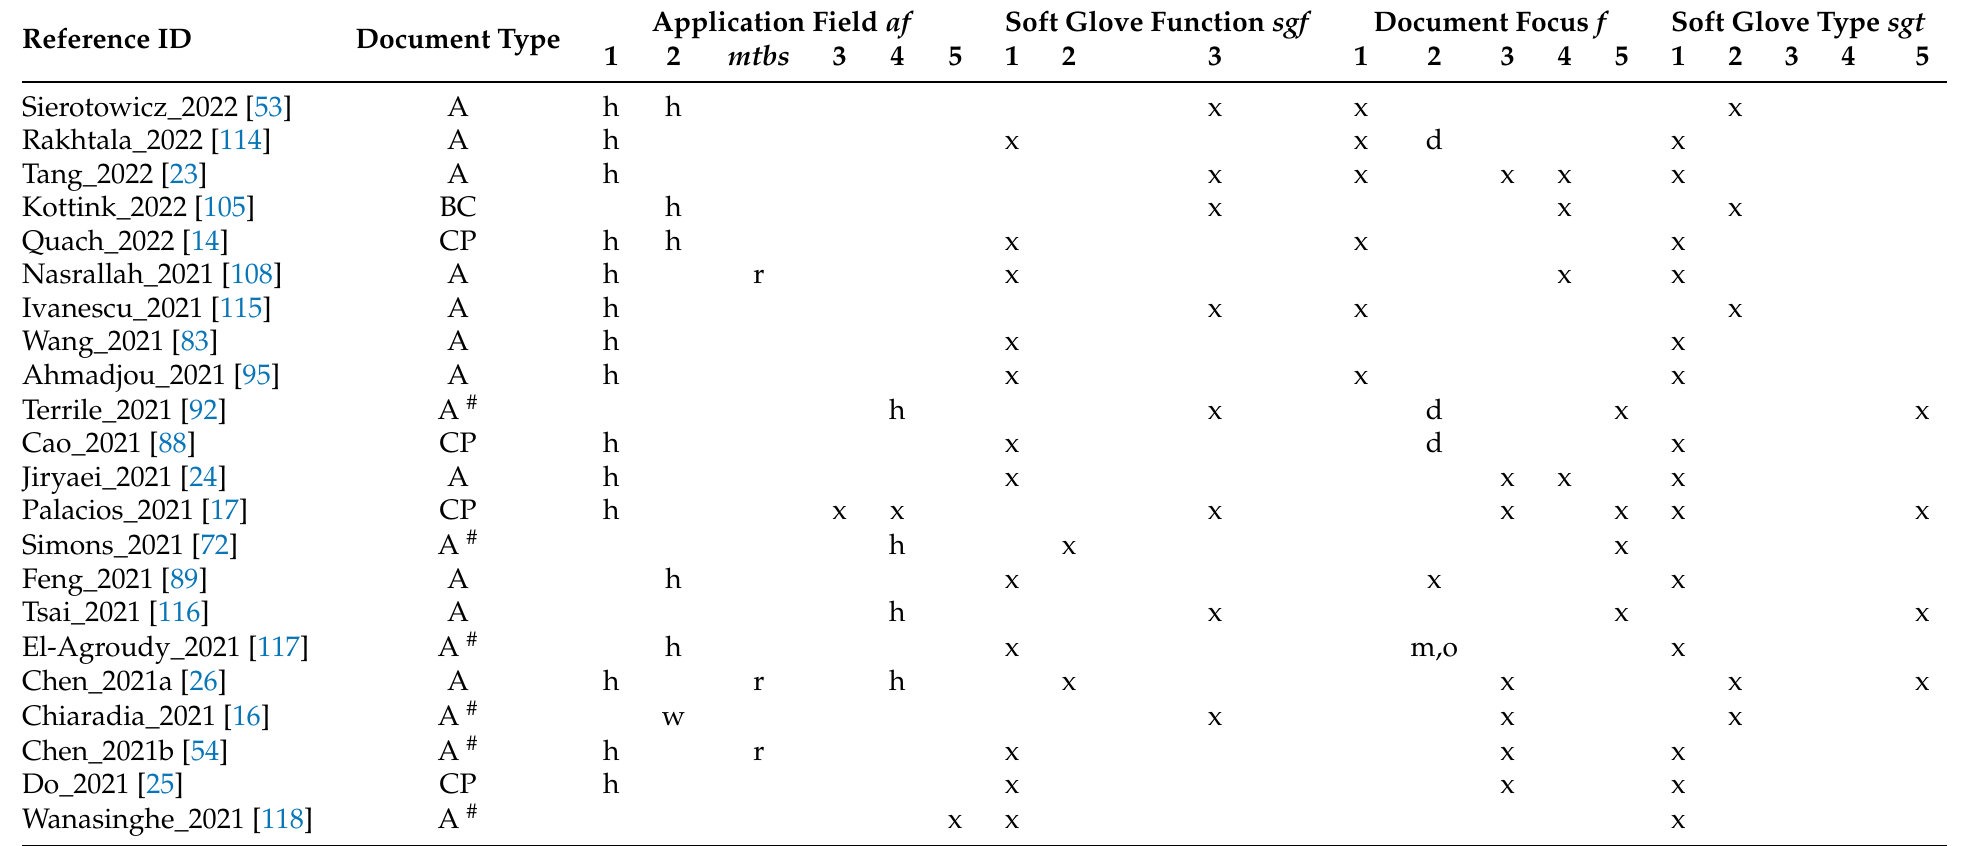
Table A1. Literature classification. From the left: reference ID) unique code of the entry; Document Type) A = article, CP = conference paper, BC = book chapter; Application Field) 1 = rehabilitation, 2 = assistance, 3 = robotic control, 4 = haptic, 5 = soft orthesis, mtbs = mirror therapy-based system (h = for hand, w = for wrist, r = for rehabilitation purposes, a = for assistive purposes); Soft Glove Function) 1 = actuation, 2 = sensing, 3 = actuation and sensing; Document Focus) 1 = control approaches, 2 = actuators, 3 = rehabilitation and assistive devices, 4 = clinical trials, 5 = sensing and haptic devices (m = modeling, d = design, o = optimization);